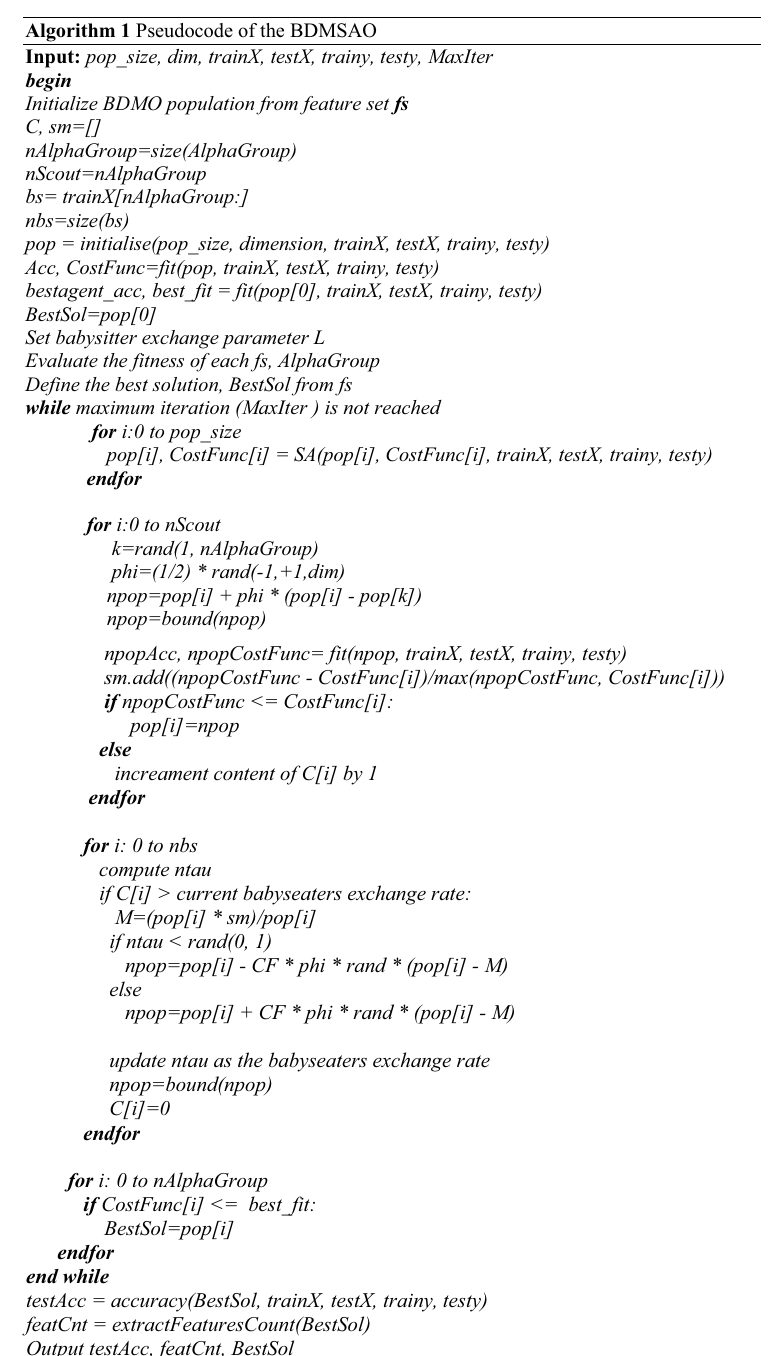
Algorithm 1 Pseudocode of the